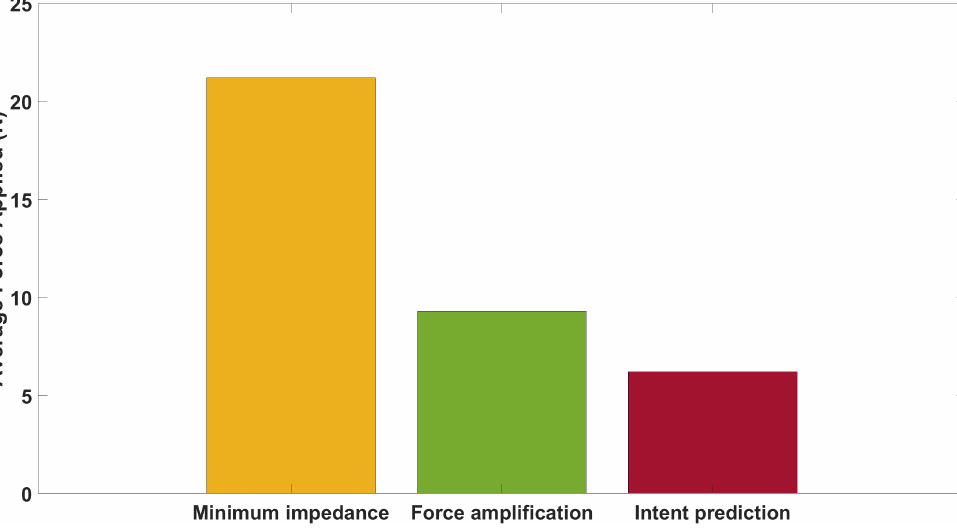
Figure 31. Comparison of different strategies with 5